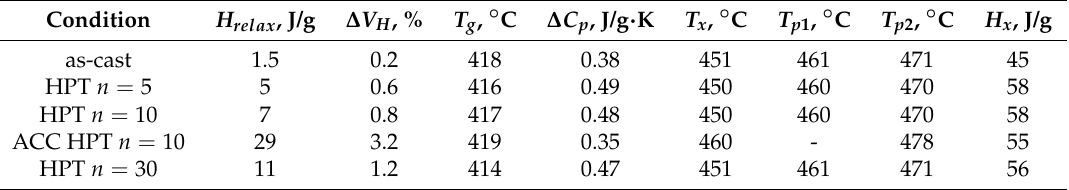
Figure 3. DSC curves for Vit105 in the as-cast state and after HPT via different regimes. Table 2. DSC data for the Vit105 BMG after HPT via different regimes HPT and accumulative (ACC) HPT.